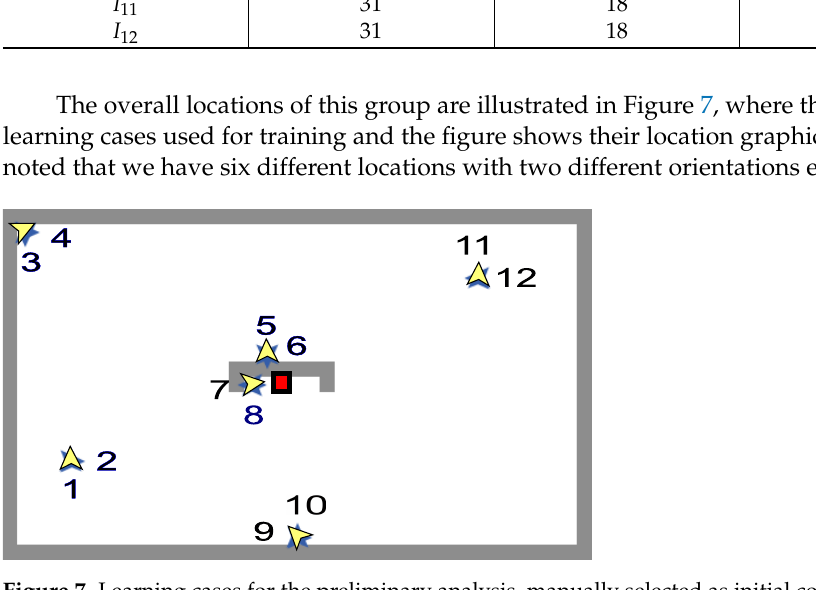
Figure 7. Learning cases for the preliminary analysis, manually selected as initial conditions to locate each robot in the navigation environment, graphically depicted by yellow arrows showing their location and orientation and in red at the middle is the